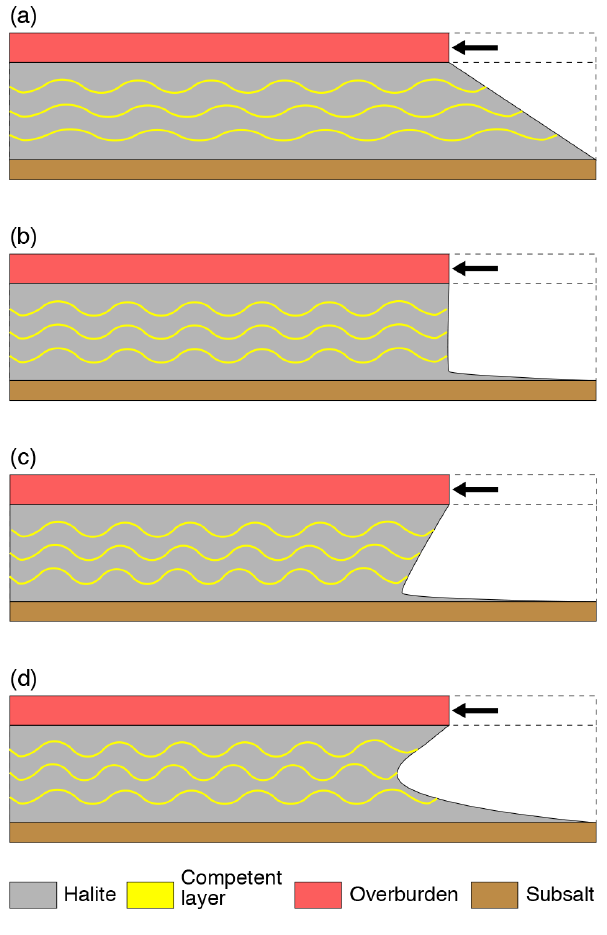
Figure 8. Different possible shear profiles during shortening (in- spired by Cartwright et al., 2012), with cover deformation not shown for the sake of simplicity: (a) Couette flow (simple shear of entire salt layer), resulting in upward increasing shortening mag- nitudes for intrasalt competent beds; (b) intrasalt basal shear, with competent beds shortened equally; (c) combined inverse Couette flow and basal shear, with intrasalt shortening decreasing upward; (d) asymmetric Poiseuille flow (or combined Couette and Poiseuille flow), with maximum shortening of intrasalt beds near the center of the salt layer.